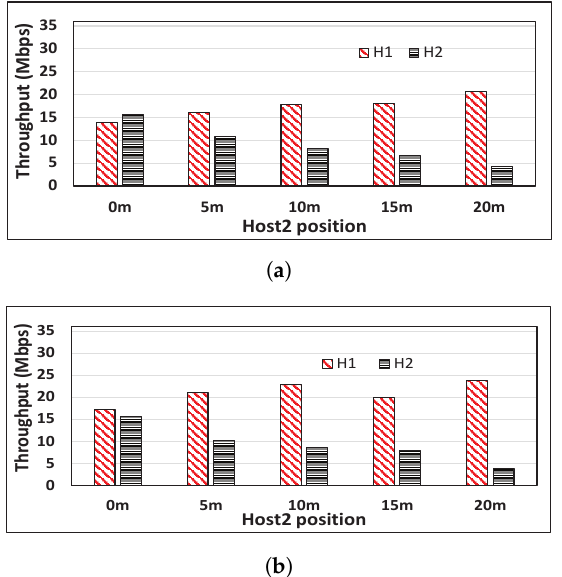
Figure 2. Throughput unfairness observations between two hosts. ( a ) Indoor result. ( b ) Outdoor